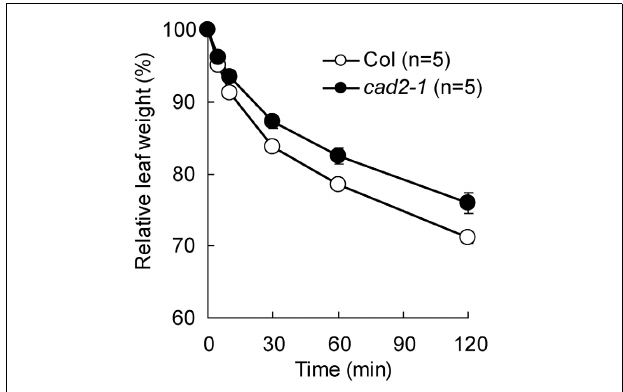
FIGURE 1 | The cad2-1 mutant shows reduced transpirational water loss. Fresh weight loss of detached rosette leaves. The bars represent the mean ± SE values of five independent